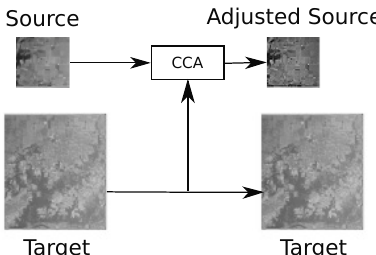
Figure 8. Conditional Correlation Alignment (CCA)